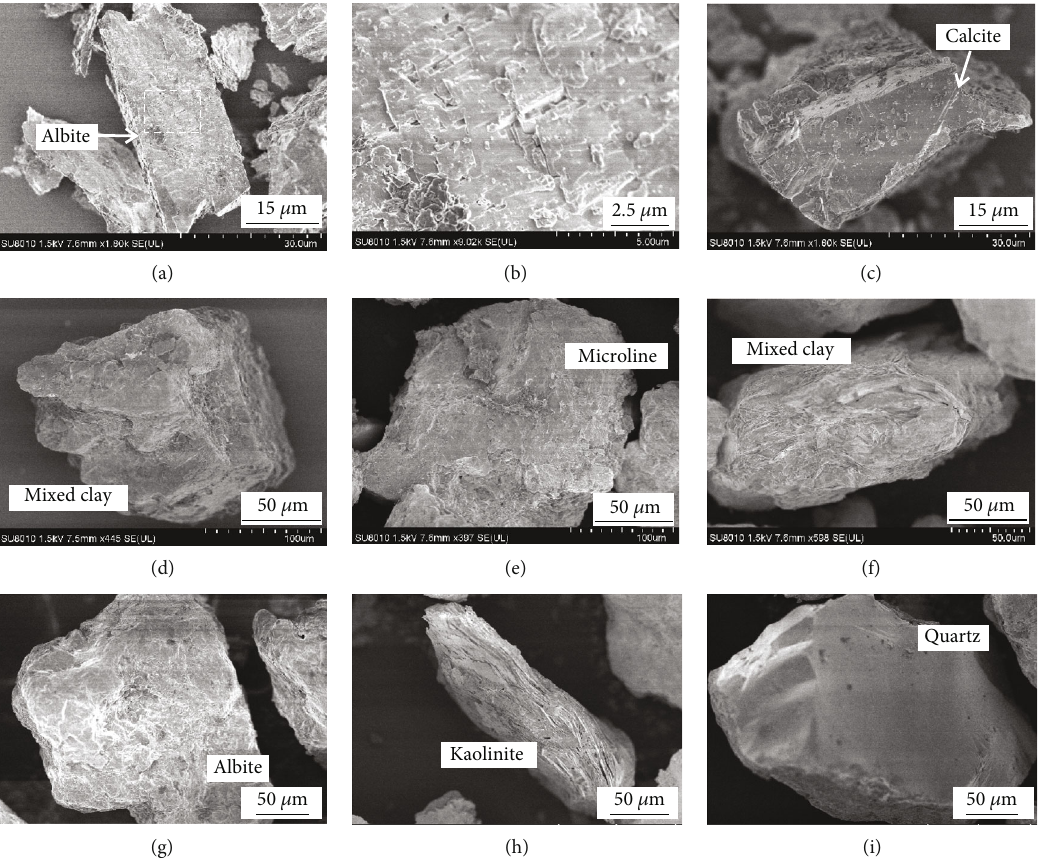
Figure 6: SEM images of initial and altered rock grains in the sandstone series. (a) Albite crystal in initial sandstone; (b) enlarged image of dotted box in 6(a) showing no pore development on the albite surface; (c) calcite crystal in initial sandstone; (d) mixed clay at 50 ° C; (e) microcline grain at 75 ° C; (f) mixed clay at 100 ° C; (g) albite at 150 ° C; (h) kaolinite with interlayer pores at 150 ° C; (i) quartz grain with smooth surface at 200 ° C. All minerals marked in this fi gure were determined by energy-dispersive X-ray